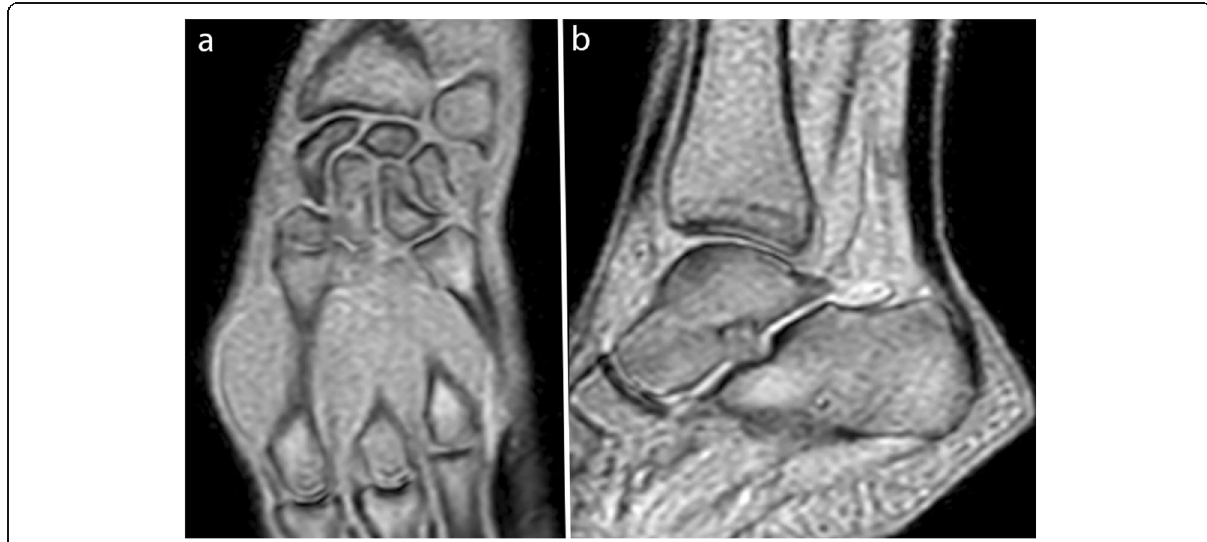
Fig. 3 Real-time dynamic MR images obtained with the RF-spoiled sequence at 3.0 T. Wrist in the coronal plane in ulnar deviation ( a ) and ankle in the sagittal plane in plantar flexion ( b ) (TR, 20.6; TE, 1.8; flip angle, 15°; pixel size, 1.3 × 1.67 mm)